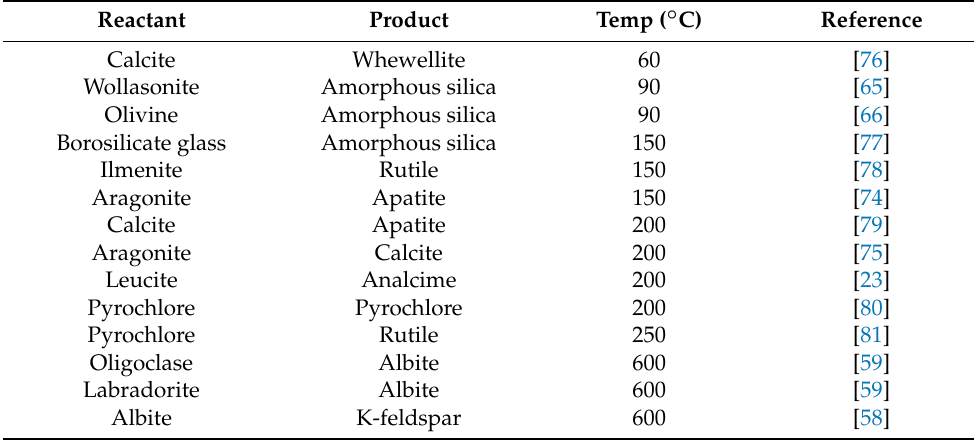
Table 1. Replacement reactions that have shown 18 O isotope incorporation into structure during mineral replacement by Raman